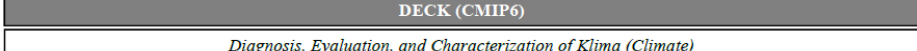
Table 3. The experiments within the DECK, as described in ES-DOC. The content of this table, like all the ES-DOC tables in this paper, was generated directly from the online documentation using a Python script (details in the Appendix). The choice of content to display was